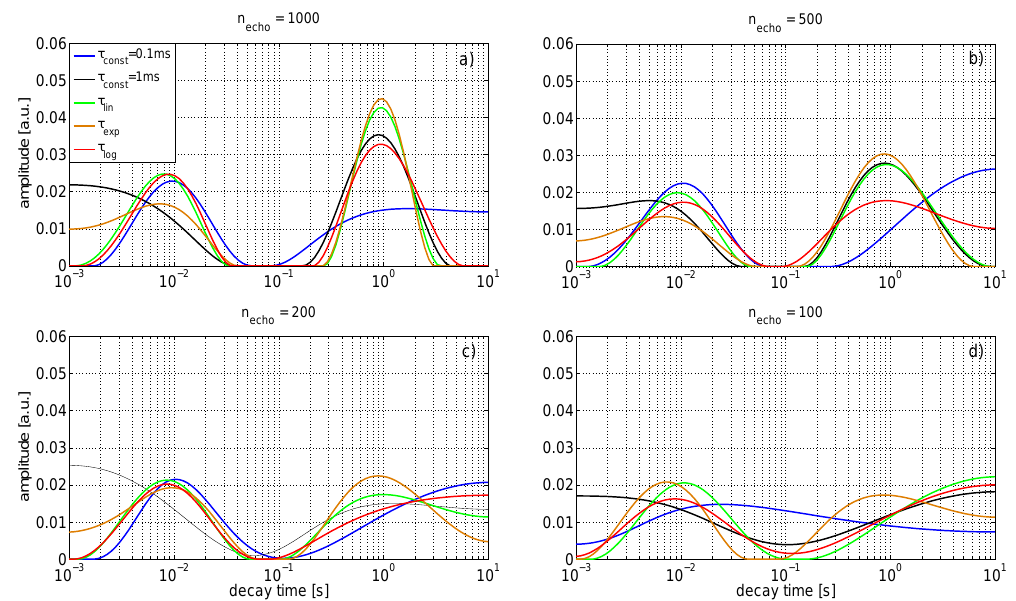
Fig. 4. T 2 distributions of bi-exponential signals with different n echo beginning with 1000 echos (a) to 100 echos (d) , all with 5% noise added. Sequences with linearly increasing, exponentially equidistant and logarithmically equidistant τ spacing with τ max=2 ms are plotted. Additionally two sequences with an constant τ spacing are